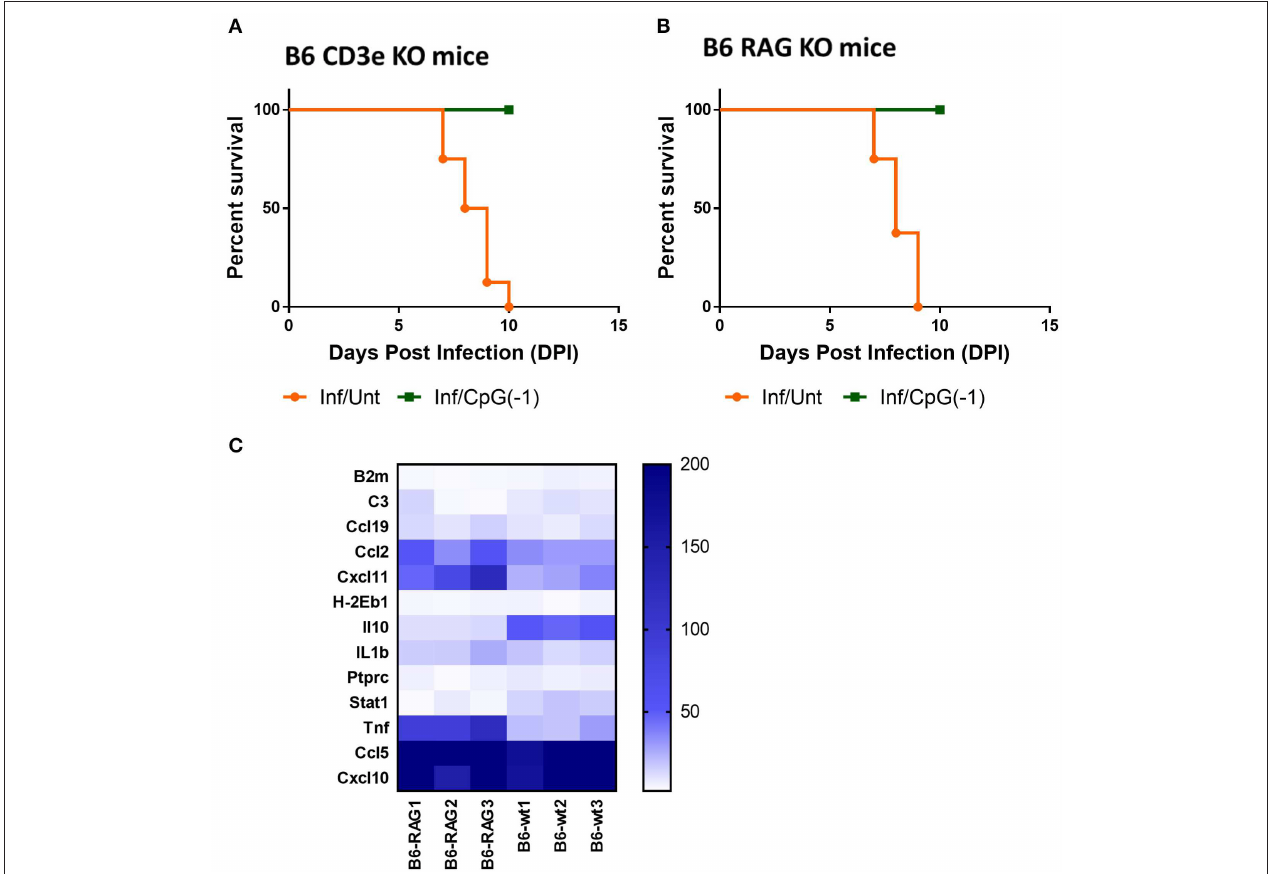
FIGURE 6 | CpG ODN mediated protection against lethal SINV infection does not require T or B cells: Survival curves of (A) B6-CD3 ε KO mice and (B) B6-RAG KO mice infected sub-cutaneously with 25 PFU SINV on P3 and treated with CpG ODN (50 µ g, IP on P2) or left untreated The data is representative of two different experiments( n > 6 mice/group). (C) mRNA expression of genes linked to innate immune response in brains of uninfected B6-WT and B6-RAG KO mice treated with CpG ODN (50 µ g IP on P2). Gene expression is expressed as fold change over mRNA levels in the brains of untreated age-matched controls. The data is representative of three different